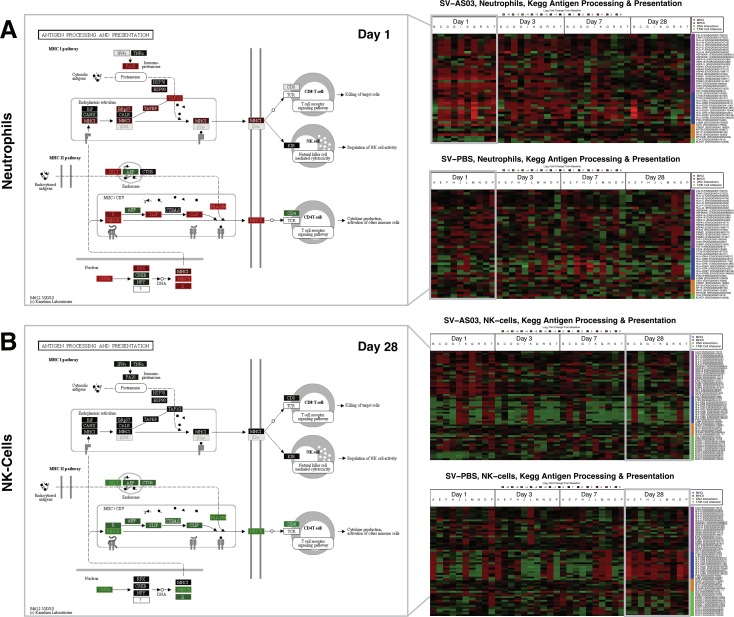
Antigen processing and presentation responses for Neutrophils and NK-cells showed increased MHC-II sub-pathway activity that differed between vaccine groups.(A) Neutrophil responses. (B) NK-cell responses. To the right: Heatmaps of subject-specific baseline log2 fold changes for KEGG Antigen processing and presentation genes across post-vaccination days by vaccine group. Colored in red: up regulated from baseline; colored in green: down regulated from baseline. To the left: KEGG pathway maps for post-vaccination days at which this pathway was significantly perturbed (day 1 for neutrophils, day 28 for NK-cells). Pathway node color gradient encodes log2 fold change difference (LFCD) between vaccine groups (for multi-gene nodes the median LFCD was used). In red: increased log2 fold change response for the SV-AS03 group relative to the SV-PBS group, in green: decreased log2 fold change response for the SV-AS03 group relative to the SV-AS03 group, and vice versa, in black: fold change close to 1, in dark grey: genes filtered out due to low overall expression, light grey: gene missing database mapping, white: non-human gene. DE genes are highlighted using red and green label colors.